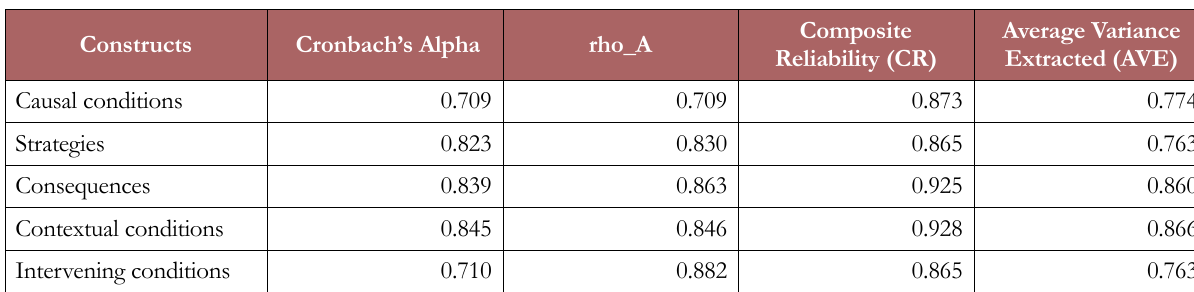
Table 11. Construct validity and reliability